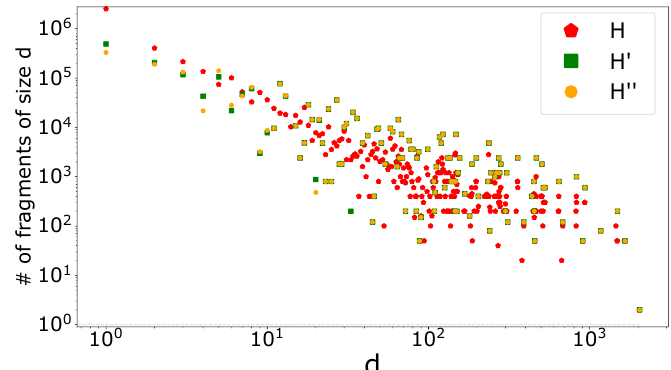
Figure 7: Fragment size distribution for the 5 × 5 lattice, for different interaction